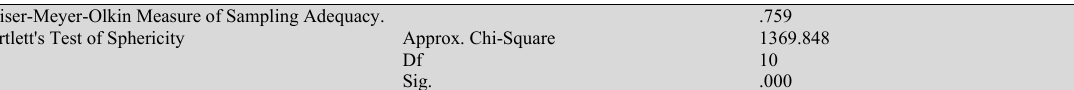
The results of KMO and Bartlett’s test Kaiser-Meyer-Olkin Measure of Sampling